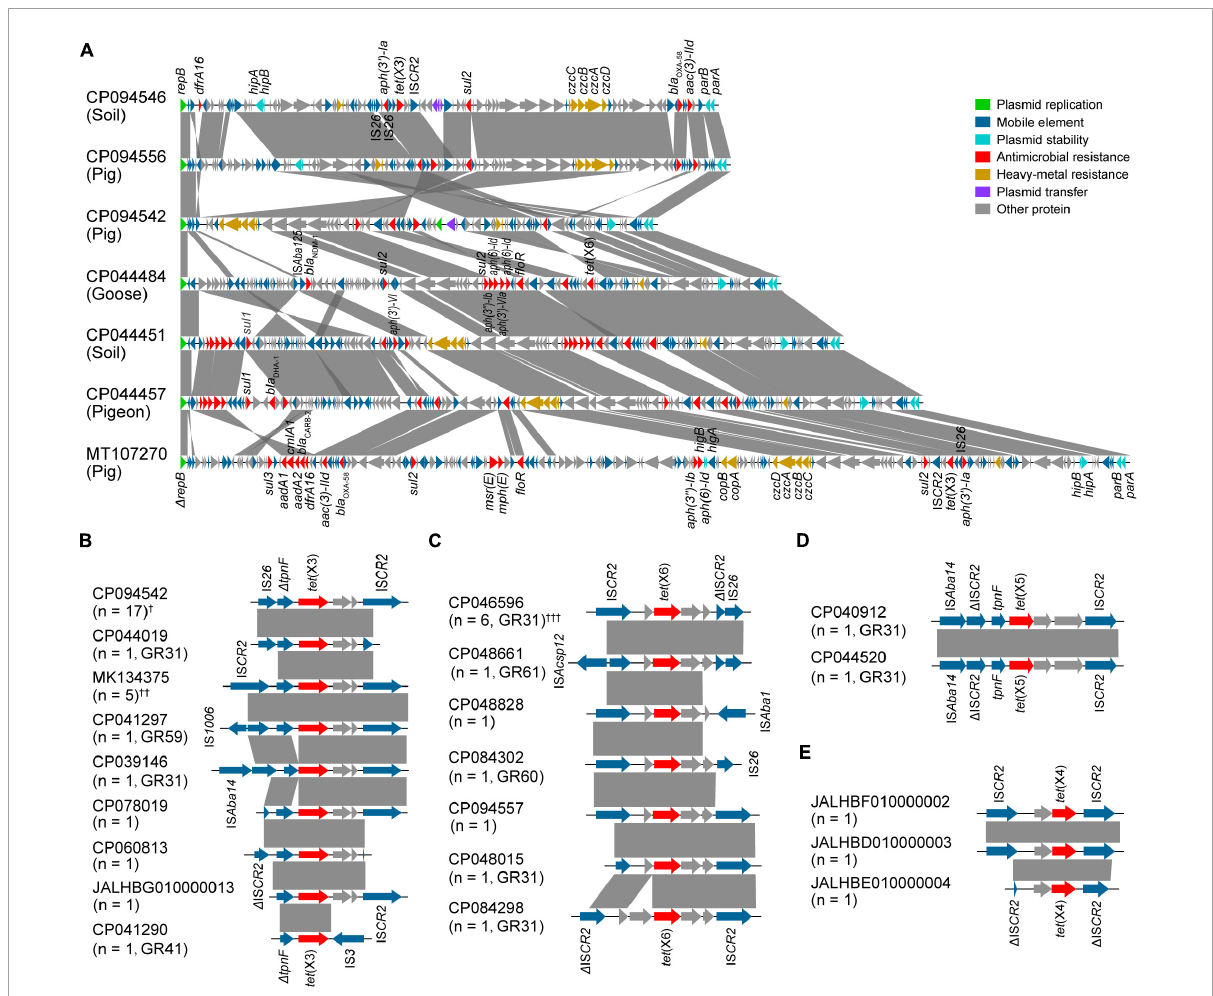
FIGURE3 Characteristics of tet (X)-carrying structures in Acinetobacter species. The arrow represents the position and transcriptional direction of ORFs, while the (cid:49) symbol indicates the gene is truncated. Regions of > 85% nucleotide sequence homology are marked by gray shading. (A) Linear sequence alignment of tet (X)-positive GR31 plasmids. The bacterial sources are listed in parenthesis. (B–E) Genetic environments of tet (X3) (B) , tet (X6) (C) , tet (X5) (D) , and tet (X4) (E) genes. The number of genetic environments and the plasmid homology groups are also given in parenthesis. † These include tet (X3)-carrying GR31 ( n = 15, e.g., CP094542), GR60 ( n = 1) and GR61 plasmids ( n = 1). †† These include tet (X3)-carrying GR26 ( n = 1, MK134375), GR31 ( n = 2), and unclassified plasmids ( n = 2). ††† All of these belong to GR31 plasmids ( n = 6, e.g.,